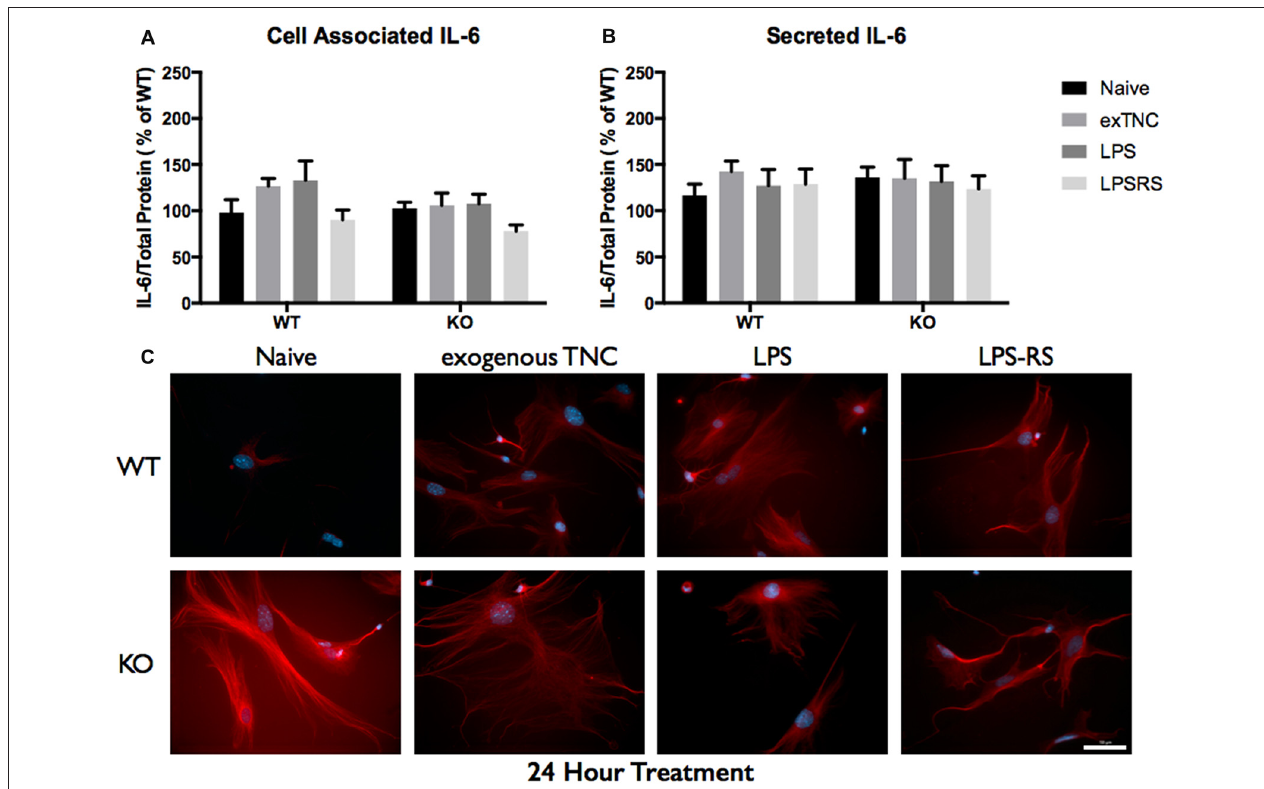
FIGURE 7 | Secreted IL-6 expression post a 24-h treatment is not significantly altered following TLR4 activation. (A) Cell associated astrocyte expression of IL-6 in WT ( n = 6/group) and FMR1 KO ( n = 6/group) astrocyte cell cultures grown for 7 days in vitro . The culture was treated with LPS (10 µ g/mL), exogenous TNC (10 µ g/mL) and LPS-RS (10 µ g/mL) for 24 h prior to collection. Representative bands were normalized to the total protein and expressed as a percentage of the average IL-6 in the WT group. (B) Extracellular astrocyte expression of secreted IL-6 in WT ( n = 6/group) and FMR1 KO ( n = 6/group) astrocyte cell cultures grown for 7 days in vitro . The culture was treated with LPS (10 µ g/mL), exogenous TNC (10 µ g/mL) and LPS-RS (10 µ g/mL) for 24 h prior to ACM concentration and collection. Representative bands were normalized to the total protein and expressed as a percentage of the average IL-6 in the WT group. (C) Cultured cortical astrocytes co-labeled with DAPI (blue) and anti-IL-6 (red) after 3 days in vitro , following a 24 h treatment. Images were obtained using a 40 × objective with a Zeiss Axioimager M2. Scale bars = 50 µ